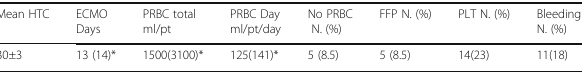
Table 34 (abstract A83). Transfusion parameters